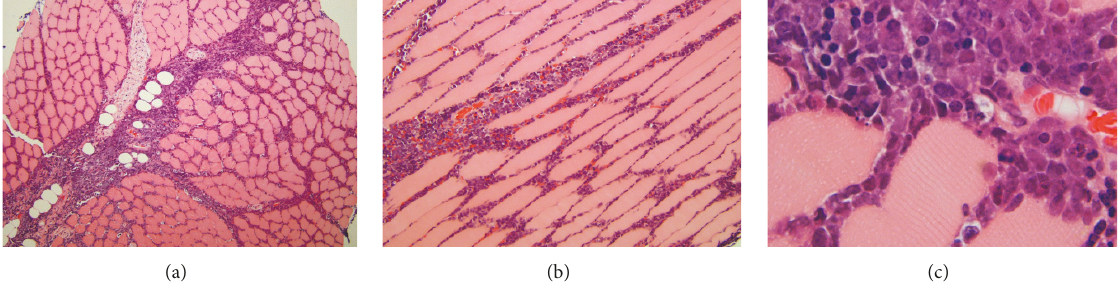
Figure 2: Transverse (a) and longitudinal (b) hematoxylin and eosin-stained histologic sections showing an infiltrate of intermediate-sized to large lymphoid cells in the endomysium between muscle fibers and the perimysium investing the fascicles or bundles of these fibers; these slides were prepared from the gluteal muscle biopsy of the 17-year-old boy described in case 1. On high magnification (c) one can observe the intimate association of the lymphoma cells with the individual striated muscle fibers.